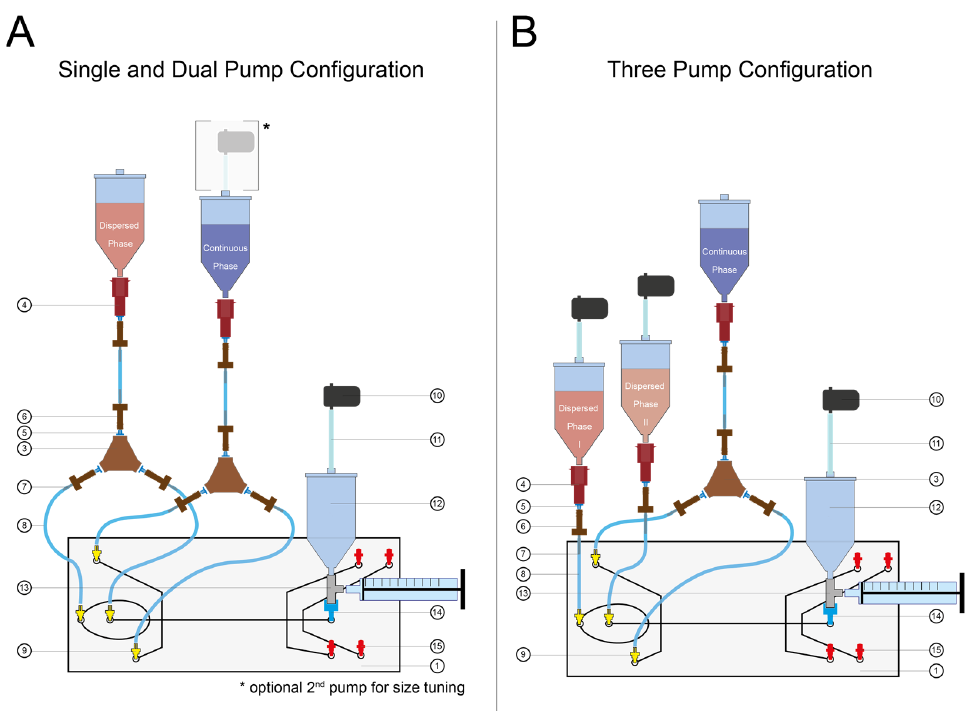
Figure 1. Schematic depictions of the minimal droplet generator setup. ( A ) Illustration of single- and dual-pump configuration. The depiction shows how the components are assembled for operating with one or two pumps; when a second pump is added to the continuous phase reservoir, larger droplets can be generated. ( B ) Schematic depiction of three-pump configuration. The illustration shows how the components are assembled for operating with three pumps. The numbers refer to the part list (see Supplementary Information). Tubing length is customizable, however, we used lengths of 7) 3 cm and 8) 5 cm, with enough overlap to ensure seal. The collection syringe can be any syringe with a Luer lock.